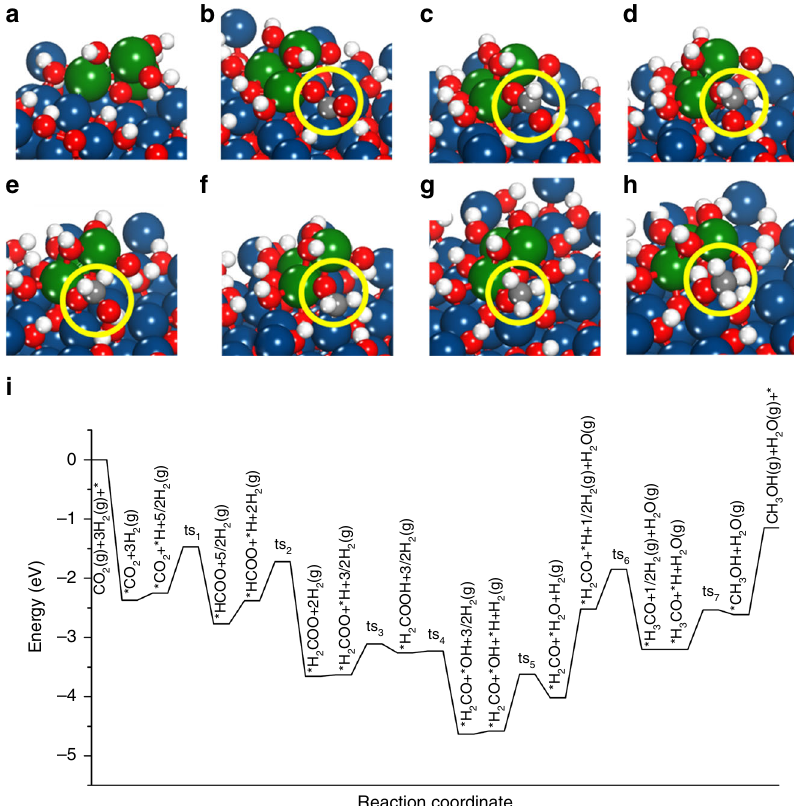
Fig. 5 Density functional theory results. a – h DFT optimized con fi gurations of a ZrO 2 /ZnO(11 (cid:1) 20) and b *CO 2 , c *HCOO, d *H 2 COO, e *H 2 COOH, f *H 2 CO, g *H 3 CO, and h *CH 3 OH adsorbed at the ZrO 2 /ZnO(11 (cid:1) 20) interface. *(X) indicates adsorbed species. The reaction intermediates are shown inside the yellow circle. Dark blue: Zn, green: Zr, red: O, gray: C and white: H. i Energy pro fi le for CO 2 hydrogenation to CH 3 OH at the ZrO 2 /ZnO(11 (cid:1) 20) interface via the formate pathway. “ ts ” corresponds to the transition